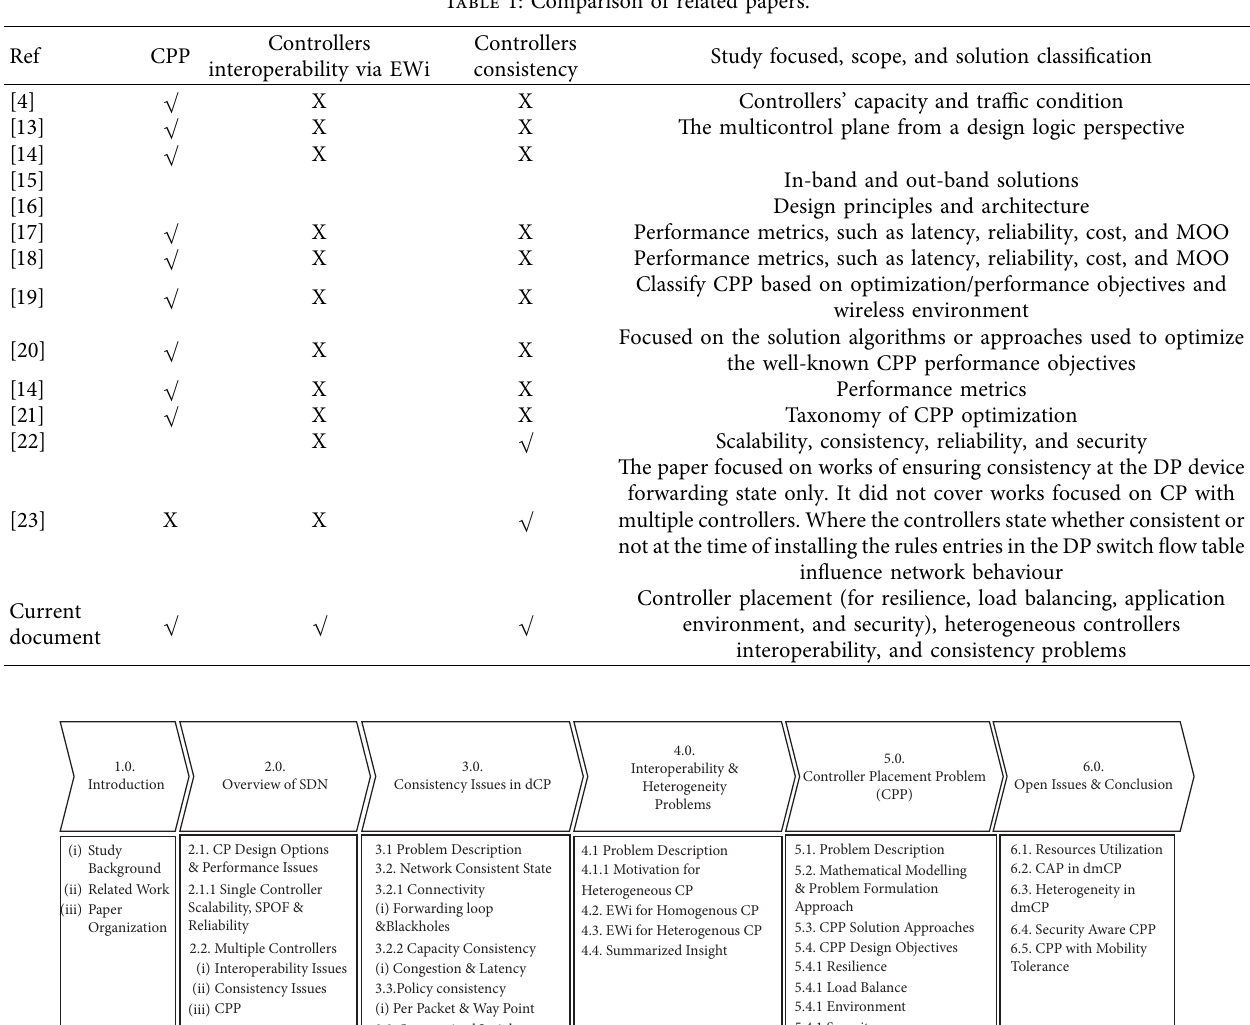
Table 1: Comparison of related papers.